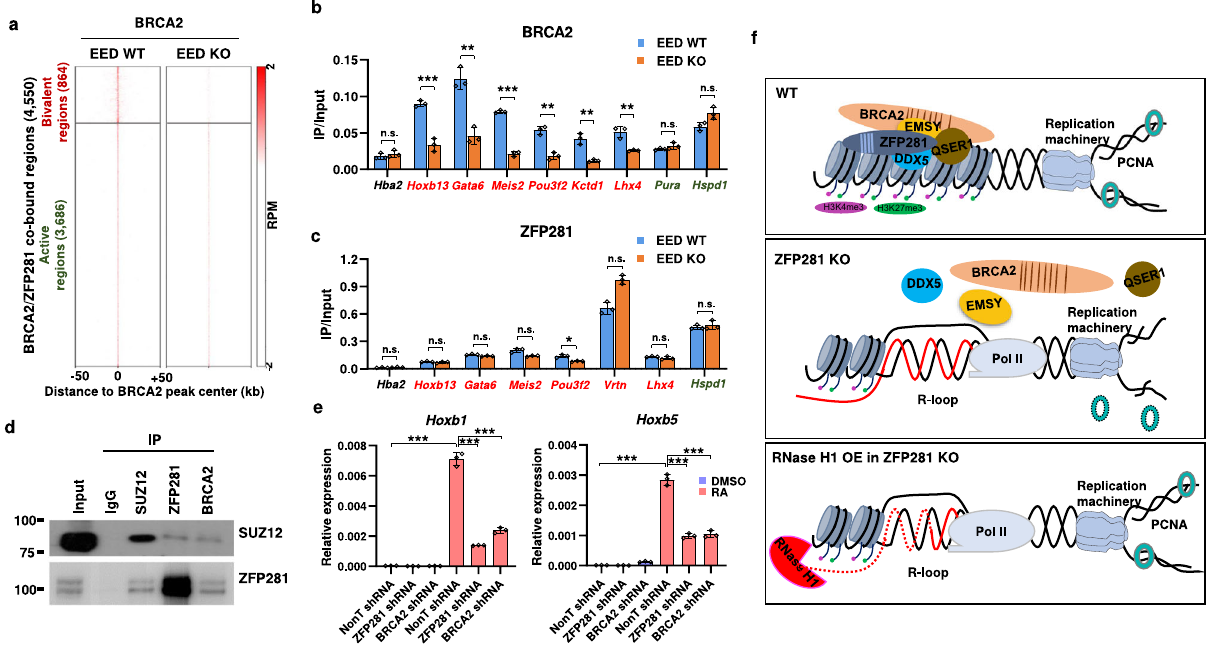
Fig. 6 BRCA2 also requires PRC2 for its binding to the bivalent chromatin. a Heat maps of the BRCA2 binding pro fi le in WT and EED KO ES cells. Shown are ±50kb of the center of BRCA2 peaks. b ChIP-qPCR showing that the occupancies of BRCA2 are reduced at the tested bivalent regions (labeled with red color) in EED KO ES cells, while remains unchanged at the tested active Pura and Hspd1 loci (labeled with green color). c ChIP-qPCR showing that the occupancies of ZFP281 remains unchanged after EED KO. b , c The HEMO gene ( Hba2 ) serves as a negative control for ChIP-qPCR. Mean ± SEM from three independent experiments. Multiple t tests were performed. ( b , Hba2 , p = 0.3989; Hoxb13 , p = 0.0006; Gata6 , p = 0.0019; Meis2 , p < 0.0001; Pou3f2 , p = 0.0012; Vrtn , p = 0.0023; Lhx4 , p = 0.0055; Pura , p = 0.1818; Hspd1 , p = 0.0564. c Hba2 , p = 0.1929; Hoxb13 , p = 0.3279; Gata6 , p = 0.1113; Meis2 , p = 0.1445; Pou3f2 , p = 0.0102; Vrtn , p = 0.0657; Lhx4 , p = 0.2136; Hspd1 , p = 0.5652.) ∗ p < 0.05, ∗∗ p < 0.01, ∗∗∗ p < 0.001, n.s. = not signi fi cant. d Endogenous immunoprecipitation analyses showing the interaction of SUZ12 with ZFP281 and BRCA2. Three independent biological repeats with similar results. e RT-qPCR showing that the induction of Hoxb5 and Hoxb1 by RA is impaired in ZFP281 KO ES cells. Results shown are technical replicates from representative biological replicates. Mean ± SEM from three independent experiments. Two-tailed, unpaired Student ’ s t tests were performed. ( Hoxb1 and Hoxb5 in NonT shRNA, DMSO vs. RA24, p < 0.0001. Hoxb1 in RA24, NonT shRNA vs. ZFP281 shRNA, p < 0.0001; NonT shRNA vs. BRCA2 shRNA, p < 0.0001. Hoxb5 in RA24, NonT shRNA vs. ZFP281 shRNA, p < 0.0001; NonT shRNA vs. BRCA2 shRNA, p = 0.0001.) ∗ p < 0.05, ∗∗ p < 0.01, ∗∗∗ p < 0.001, n.s. = not signi fi cant. f Cartoon model showing that ZFP281 functions together with BRCA2 to facilitate DNA replication through preventing R-loop accumulation in the bivalent chromatin (upper panel). ZFP281 depletion impairs the binding of BRCA2 to the bivalent chromatin, leads to aberrant R-loop accumulation and subsequent replication defects (middle panel). RNase H1 overexpression in ZFP281 knockout cells is able to rescue the DNA replication defects caused by ZFP281 knockout (lower